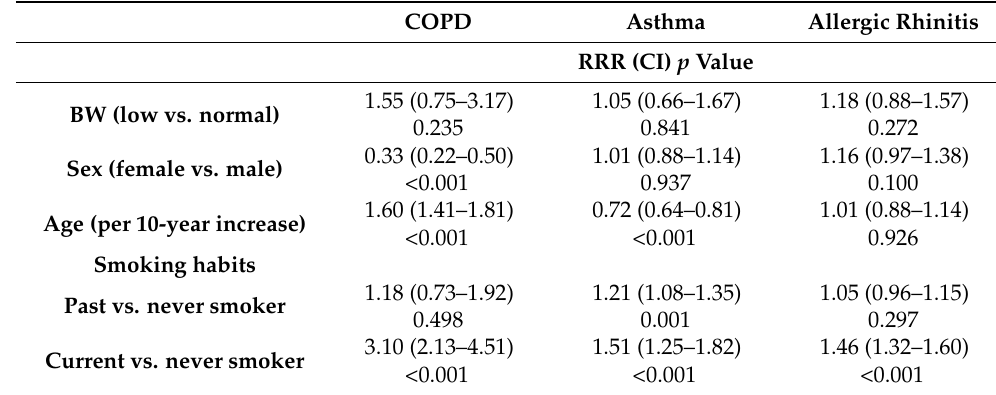
Table 5. Association of case status with birthweight with adjustment for sex, age and smoking status (n = 2049). RRR with 95% CI and p values were computed by a multinomial logistic regression, where standard errors were adjusted for intra-centre correlation.